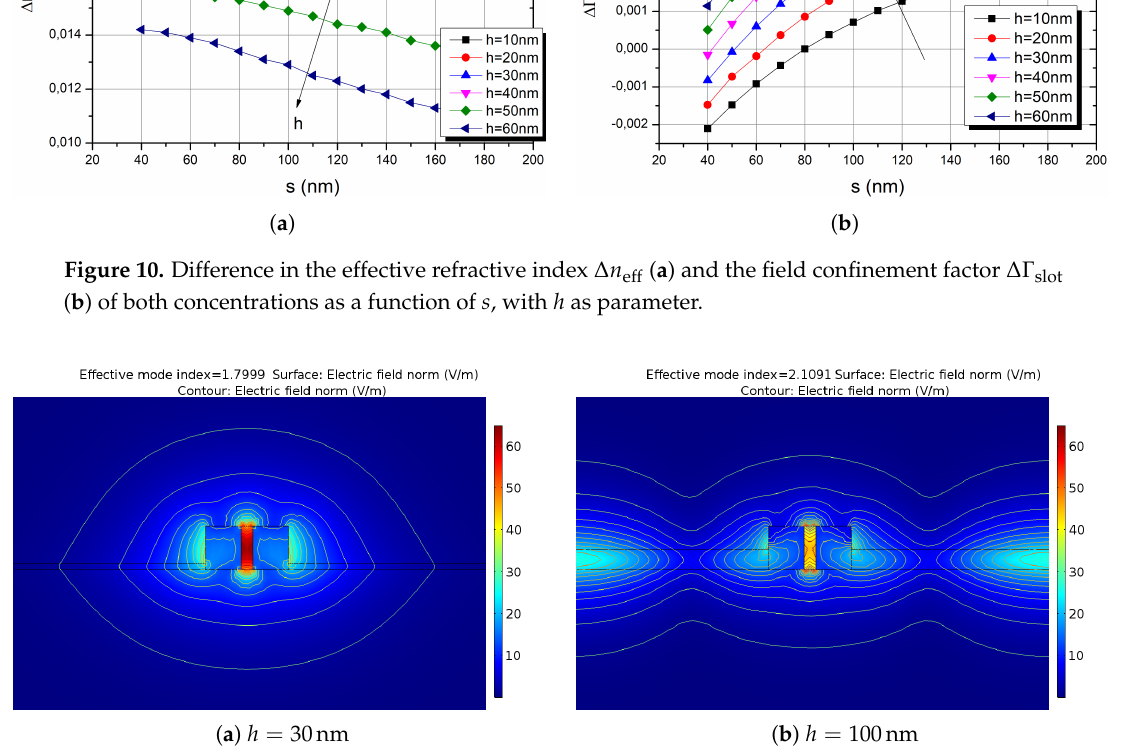
Figure 11. Influence of the slab height h on the modal properties. Higher modes propagating into the slab can be found for h >